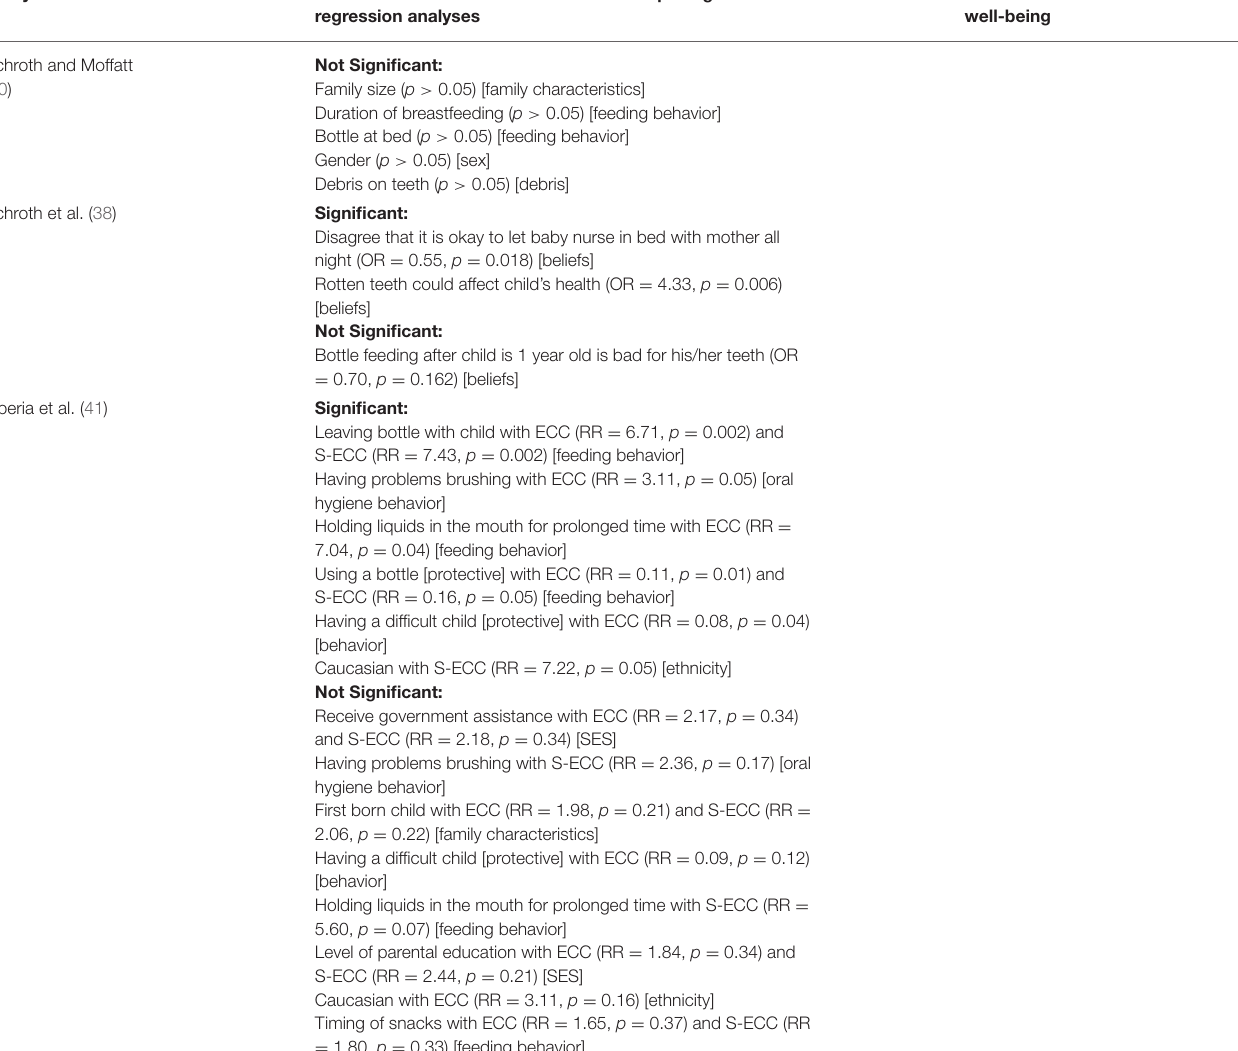
regression analyses